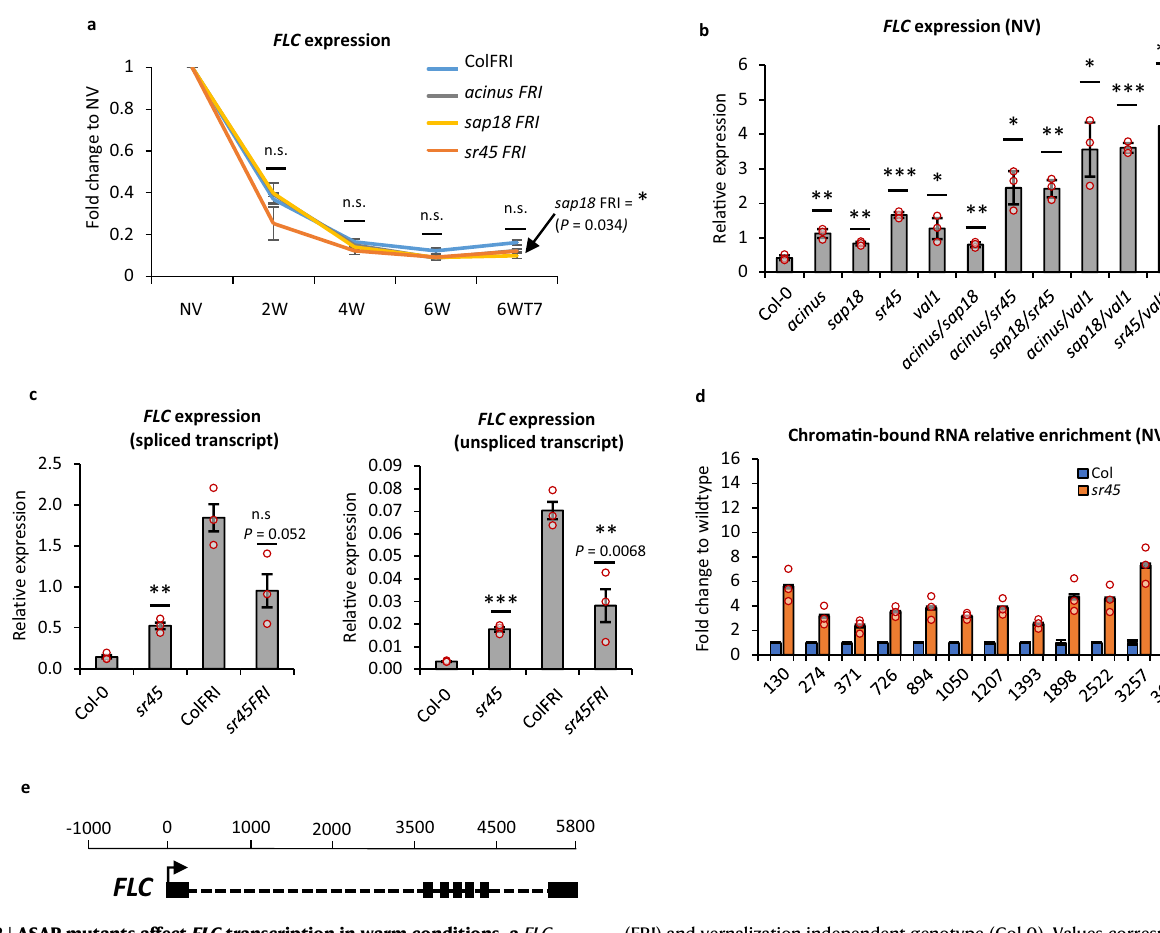
(FRI) and vernalization-independent genotype (Col-0). Values correspond to the mean relative expression to UBC . Signi fi cance tests compare Col-0 vs sr45 and ColFRI vs sr45FRI . N =3 biological replicates, error bars=SEM. d Chromatin-bound FLC RNA enrichment over the locus. Data were shown as fold change to wildtype. X-axis shows the midpoint of the amplicon relative to FLC transcriptional start site (TSS). N =3 biological replicates, error bars=propagated SEM. Statistics are cal- culated with two-tail Student ’ s t -test in comparison to wildtype (* P ≤ 0.05; ** P ≤ 0.01; *** P ≤ 0.001). e FLC gene model schematic. The scale bar indicates the position relative to the transcriptional start site (TSS), where